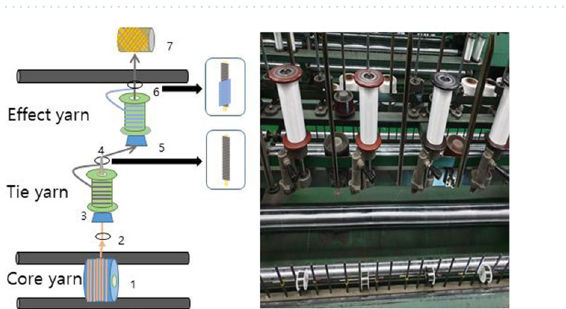
Figure 2. ( a ) Side-view scanning electron micrography (SEM) image of PET fiber yarn containing BaSO 4 ; ( b ) cross-section microscopic image; ( c ) schematic diagram of composite yarn forming a double layer on the BaSO 4 -containing PET yarn on a tungsten wire; ( d ) SEM image of the manufactured tungsten composite yarn.